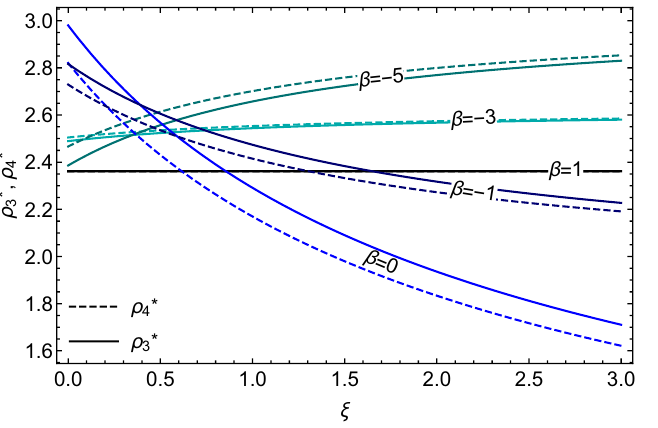
Figure 9 . Critical exponent as a function of (cid:3) for di(cid:11)erent gauges and G = 1. The solid and dashed lines correspond to (cid:2) 3 and (cid:2) 4 , respectively.